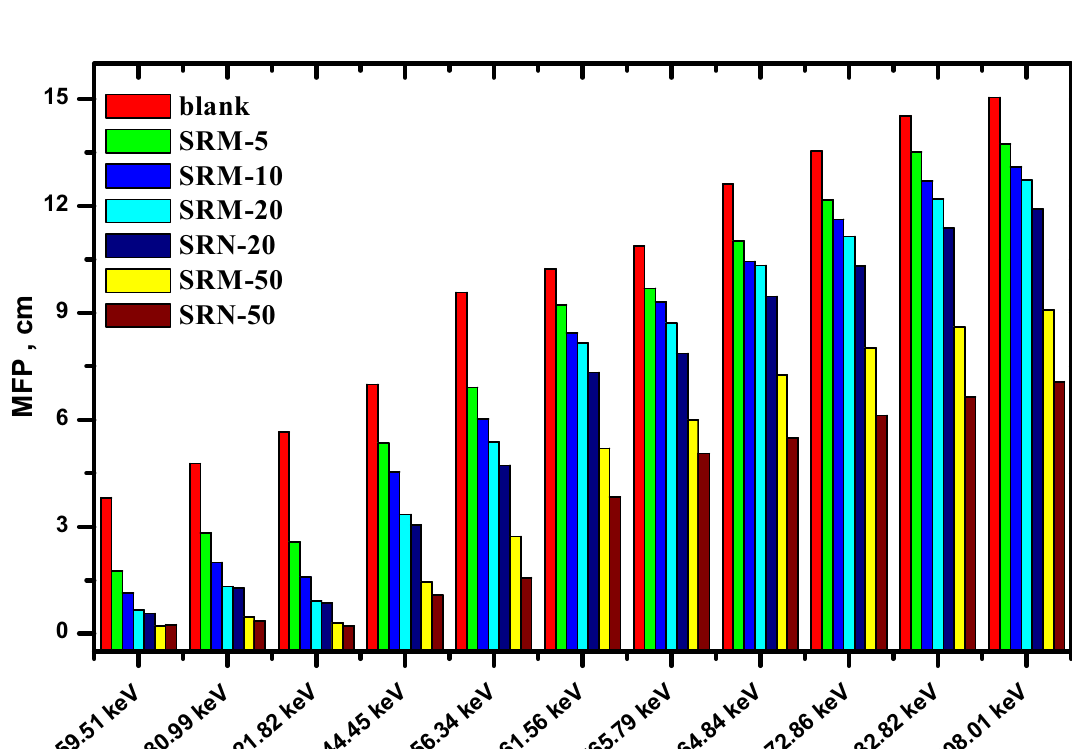
Figure 11. Mean free path value at different concentration and at different